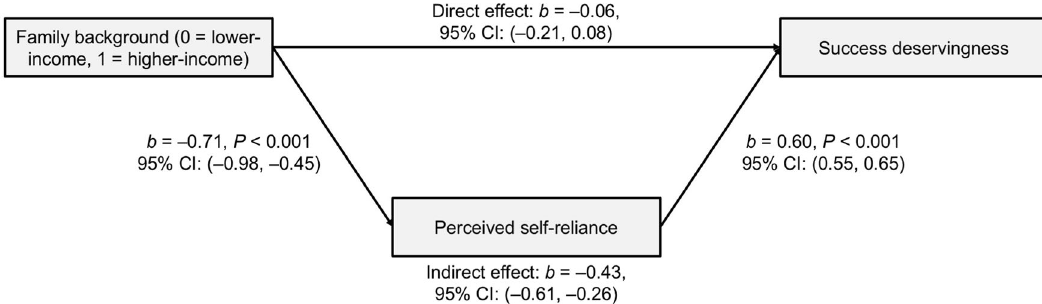
Fig. 2 Mediation results. Mediational paths of family background on success deservingness through perceived self-reliance for